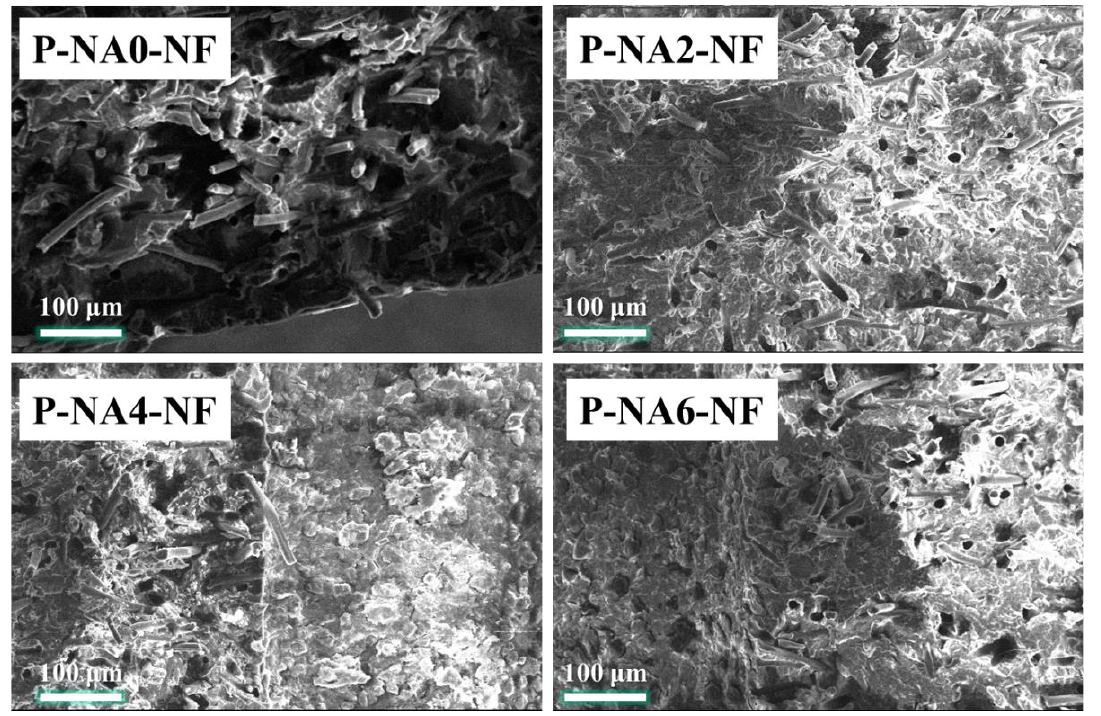
Figure 7. Scanning electron microscopy images of the fractured surfaces of NF-reinforced PLA composites with different NA contents.